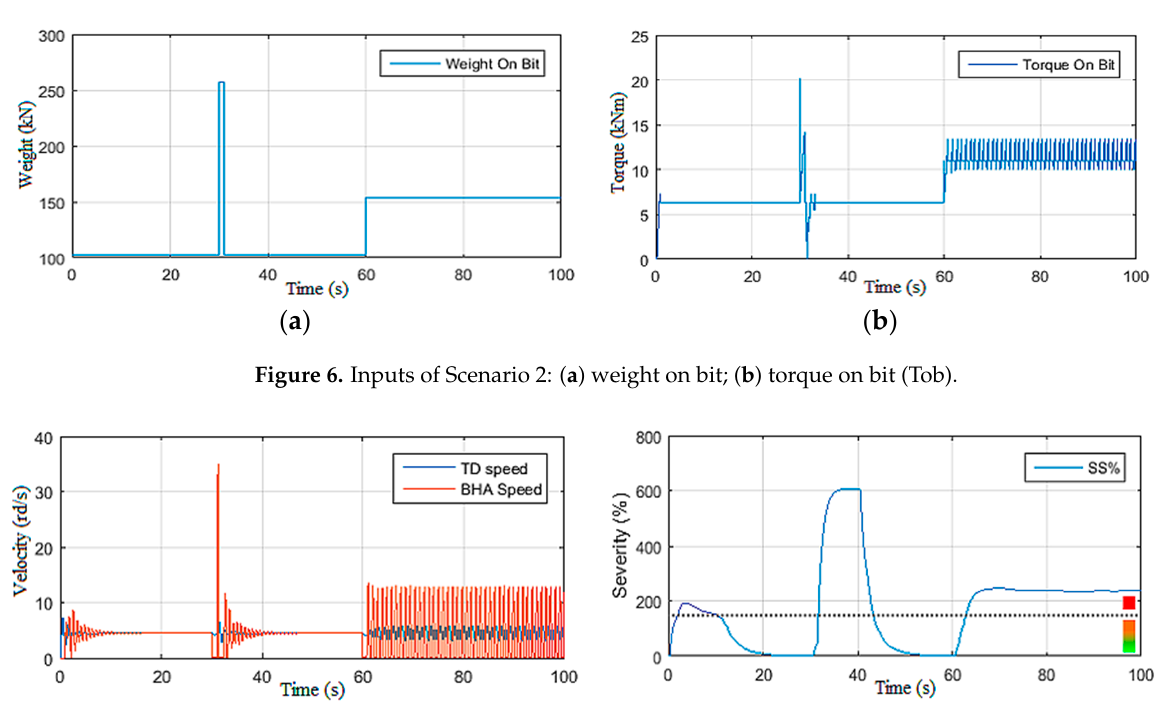
Figure 5. Outputs of Scenario 1 : ( a ) drill bit speed; ( b ) stick-slip severity.